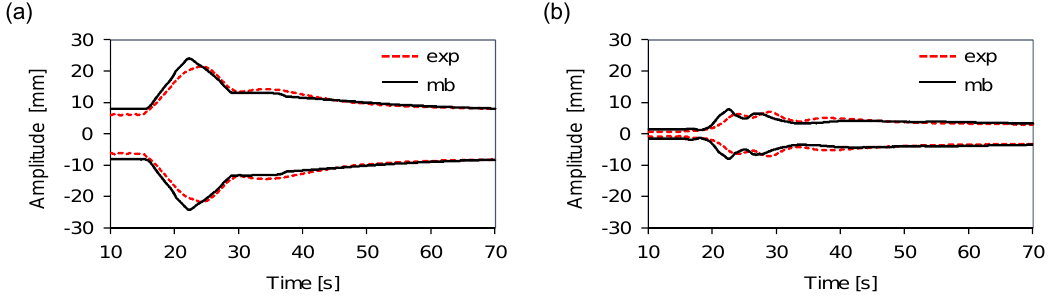
Figure 9. Multibody and experimental displacement envelopes: ( a ) X r back load; ( b ) Y f front